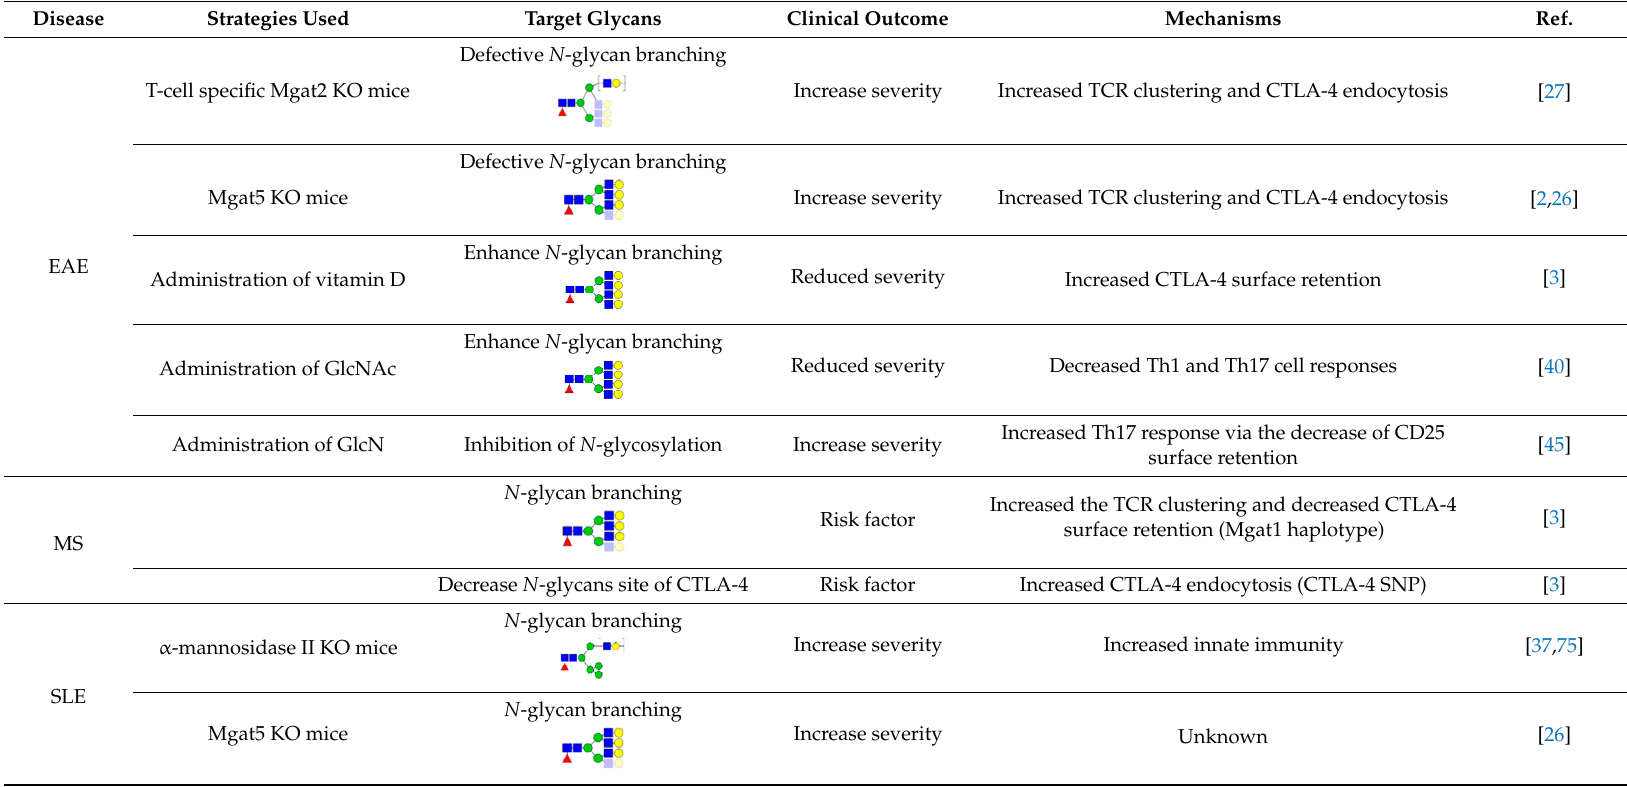
Table 1. The modulatory effects of glycosylation in T-cell-mediated autoimmune diseases.